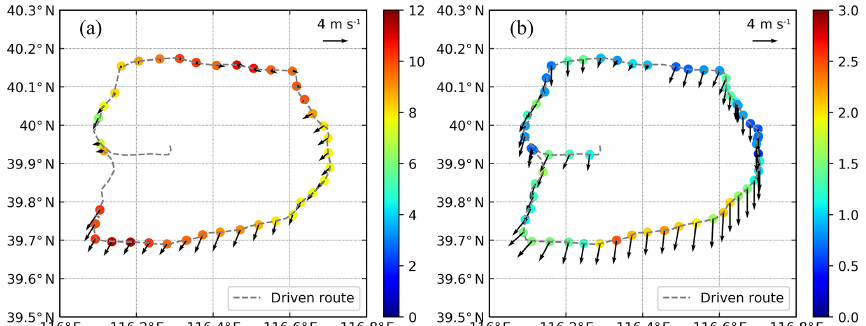
Figure 6. Distributions of the maximum and minimum NO 2 VCD (10 16 molec.cm − 2 ) on the 6th Ring Rd of Beijing on the morning of (a) 23 January and (b) 13 October 2014.